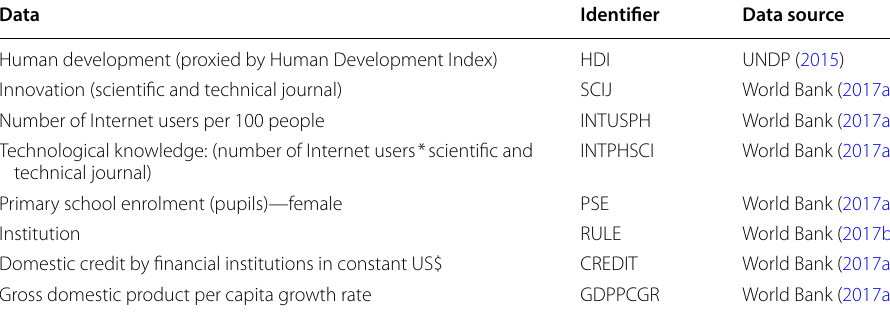
Table 1 Variables definition, mean and source of data. Source : compiled by the authors